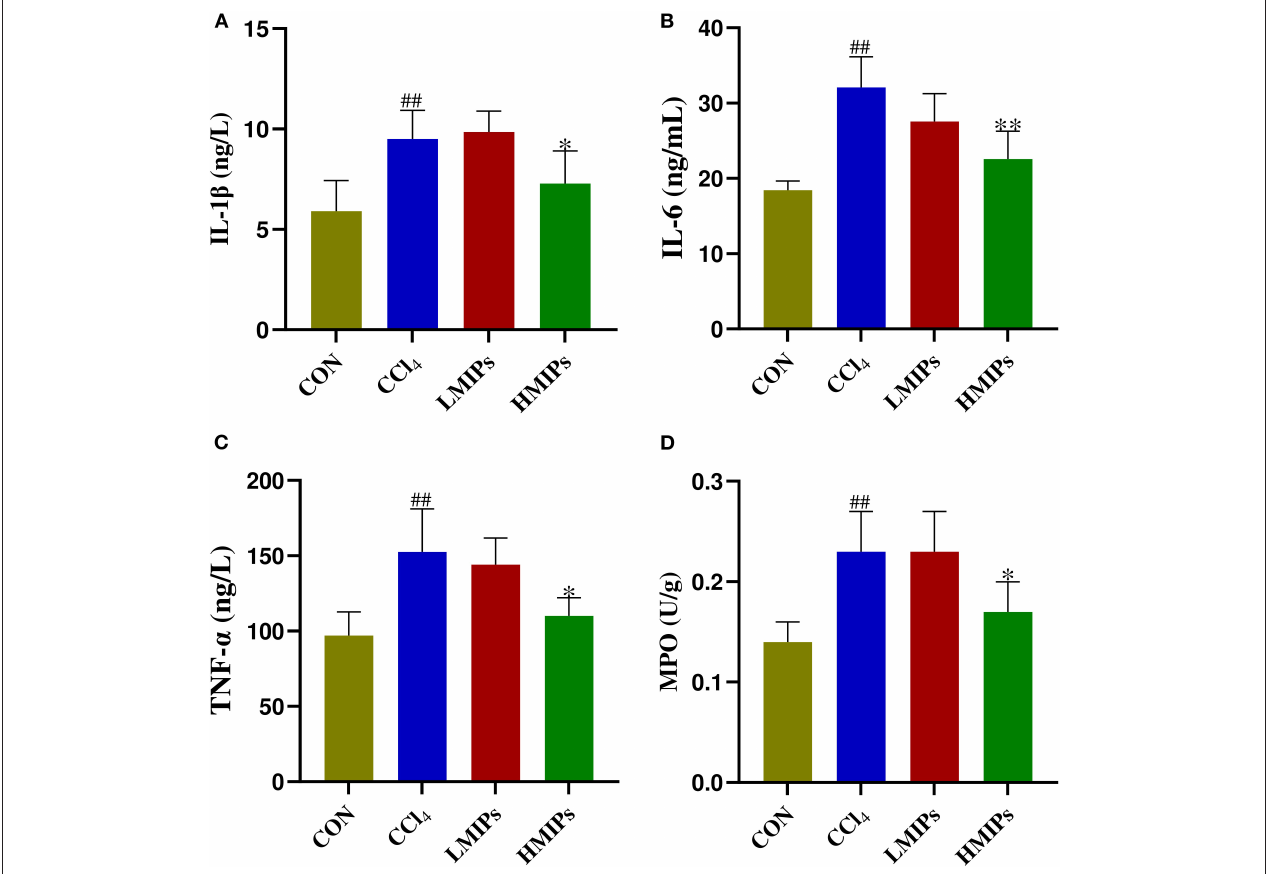
FIGURE 5 | Effect of MIP infusion on hepatic inflammation. The content of hepatic interleukin-1beta (A) , interleukin-6 (B) , tumor necrosis factor-alpha (C) , and myeloperoxidase (D) was determined by ELISA kits. The values are reported as the mean ± SD of six mice per group: (##) P < 0.01 compared with the control group and (**) P < 0.01 and (*) P < 0.05 compared with the CCl 4 -treated group.